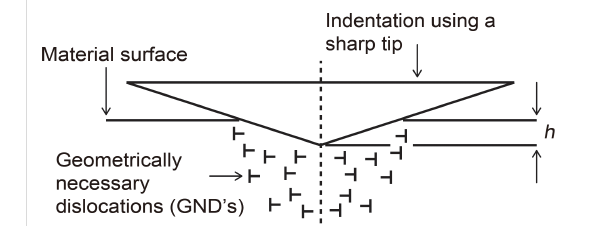
Figure 2: Illustration of the strain gradient plasticity theory in which high strain gradients occur at shallow indentation depths with a sharp tip. This leads to geometrically necessary dislocations (GNDs) being generated to accommodate for the strain gradient and a subsequent permanent deformation. The GNDs entangle and impede further movement of existing dislocations as well as the formation and move- ment of new